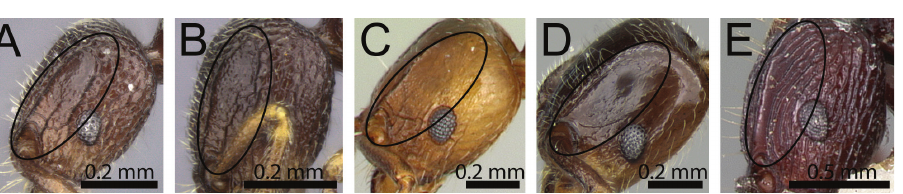
Figure 10. Lateral head in profile (antennal scrobe area within black ellipses). A T. ibycterum (CASENT0056460) B T. fhg-bilb (CASENT0448625) C T. artemis (CASENT0481732) D T. tyrion